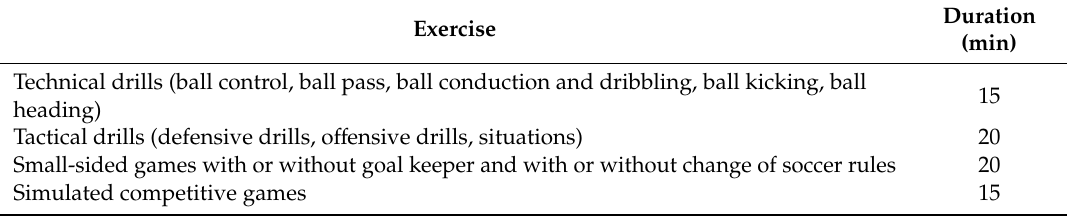
Table 1. Usual soccer training session of young soccer players during